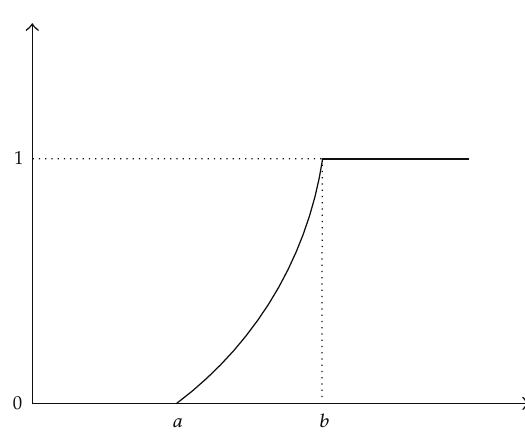
Figure 2: Membership function used for eigenvector of